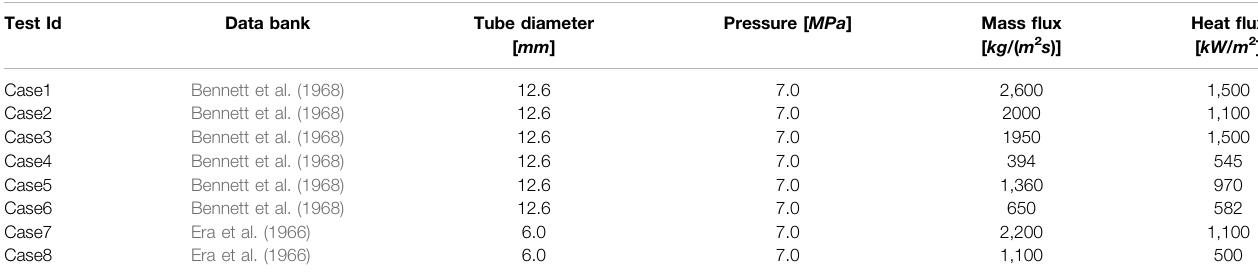
TABLE 5 | Parameters of tests for assessment of the optimized scaling